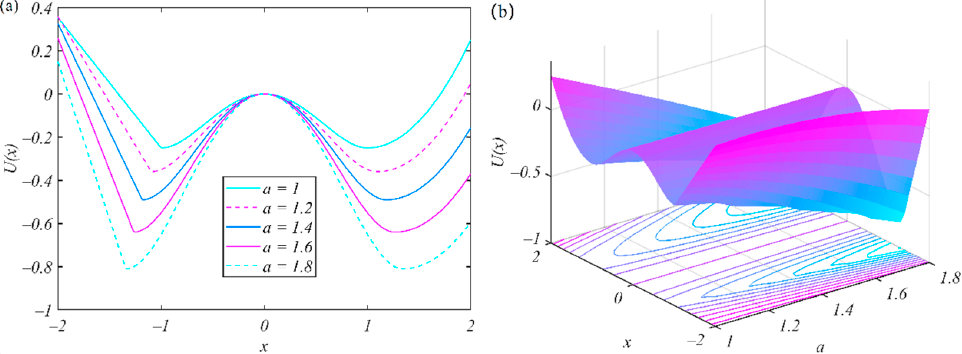
Figure 3. Comparison of output signals of CBSR and PNABSR models: ( a ) CBSR; ( b ) PNABSR. ( D = 0, f 0 = 0.01 Hz, f s = 10 Hz).